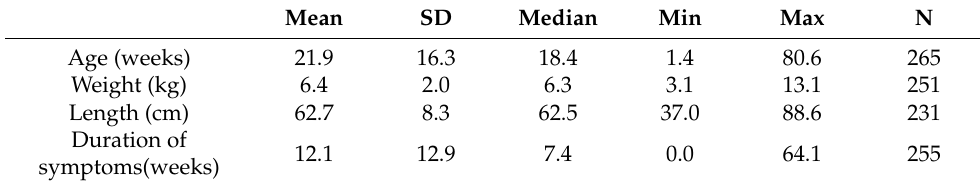
Table 2. Baseline characteristics of the 268 included infants.